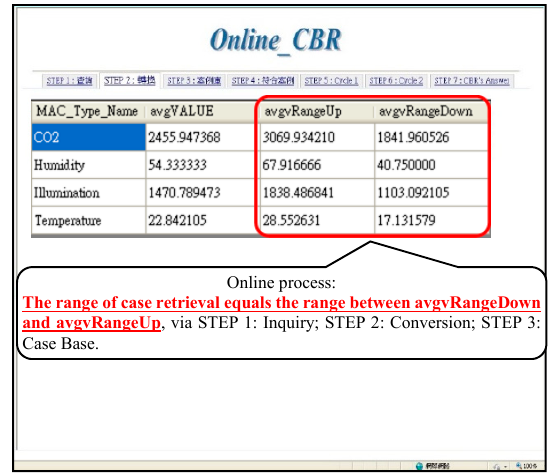
Figure 15. Case retrieval range.